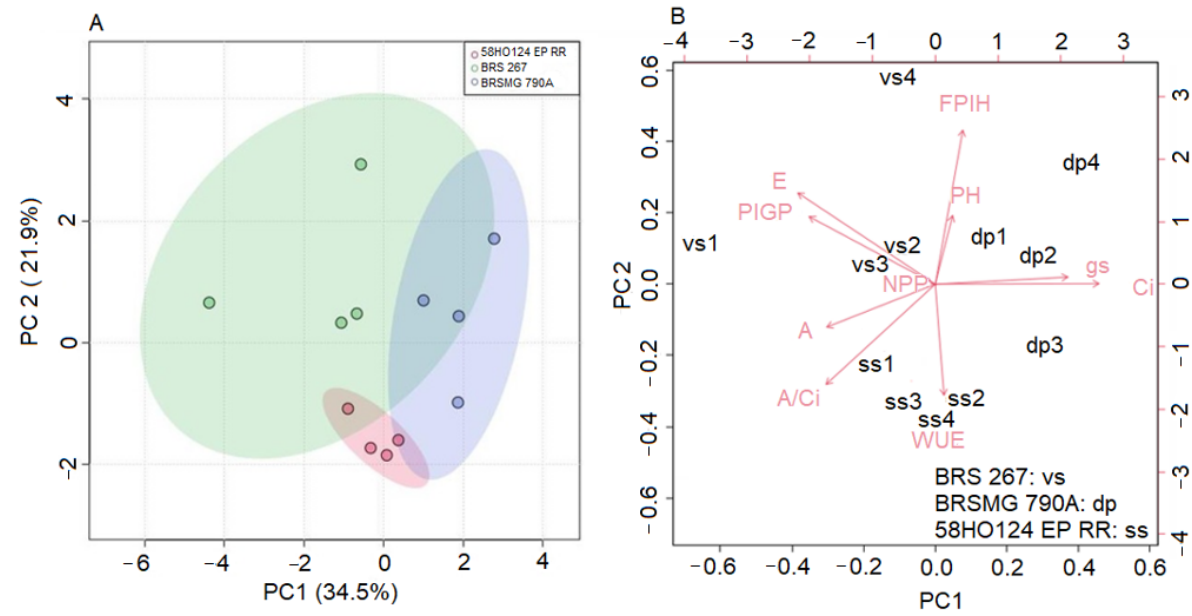
Figure 4. Score plot ( A ) and biplot ( B ) of the first two principal components of agronomic traits and gas exchange of soybean cultivars. Botucatu, SP, Brazil, 2021.